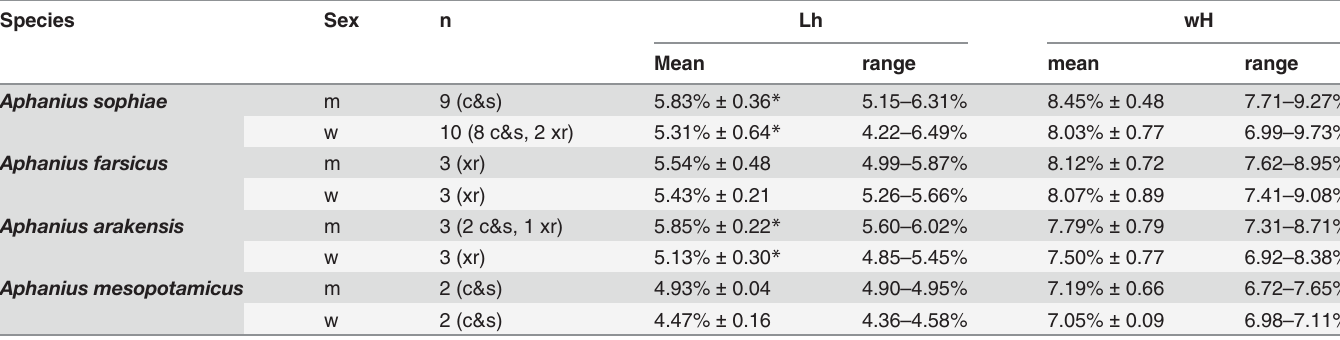
Table 4. Hypural plate dimensions of the four species of Aphanius used for comparison.